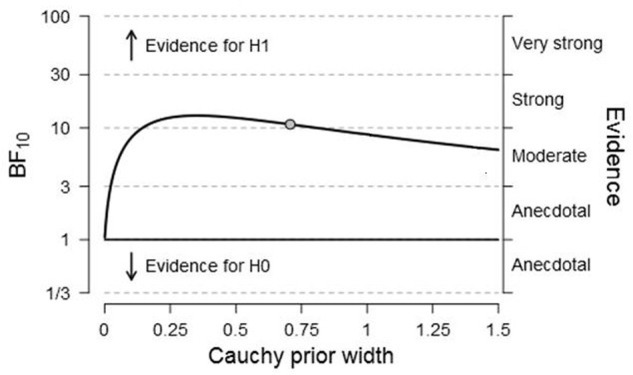
Bayes Factor for the comparison between retrieval practice and reread-plus-statements (Experiment 2) as a function of the scale parameter r of the Cauchy prior for effect size under the alternative hypothesis. The dot indicates the used prior width of r = 0.71. Figure adjusted from JASP, jasp-stats.org.